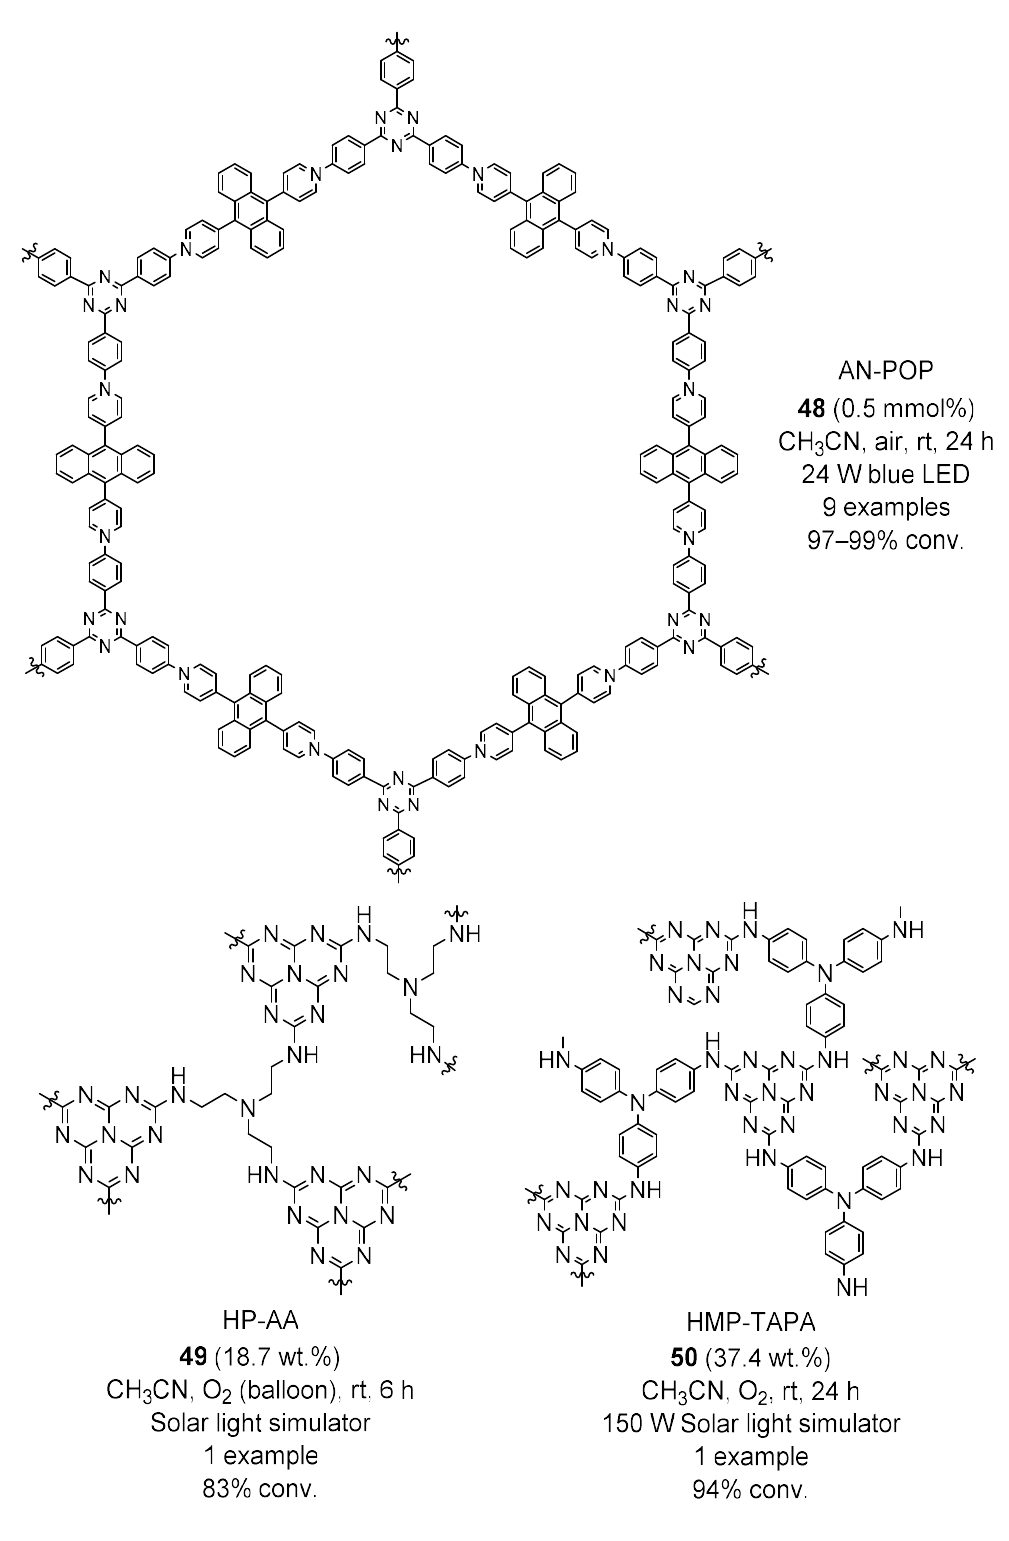
Figure 9. Results obtained in the aerobic photo-oxidative coupling of benzylamines to N -benzylidene benzylamines 2 catalyzed by 48 – 50 . Other polymers recently employed in the same reaction leading to 2 were a melamine- based material (SC-HM, 51 ) [115], a nanogel composed of poly( N -isopropylacrylamide), N -(4-(7-(phenylbenzo[ c ][1,2,5]thiadiazol-4-yl)phenyl)acrylamide and